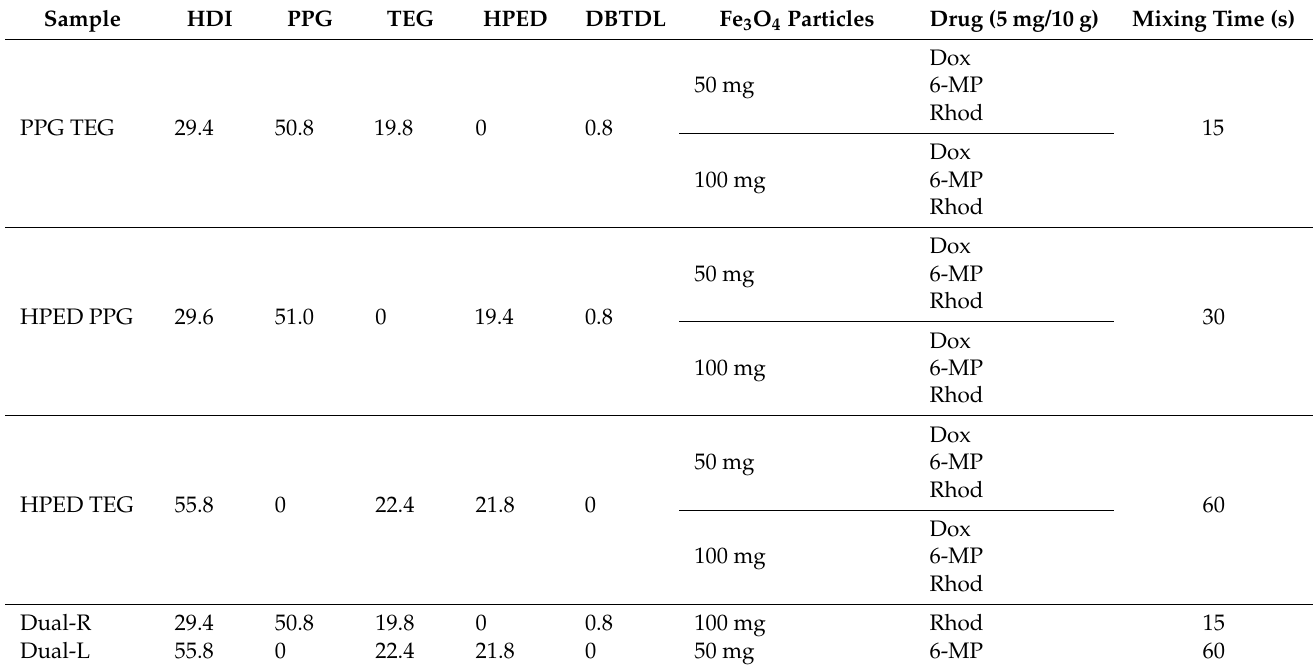
Table 1. Components of synthesized polymer film compositions in wt% with catalyst amount